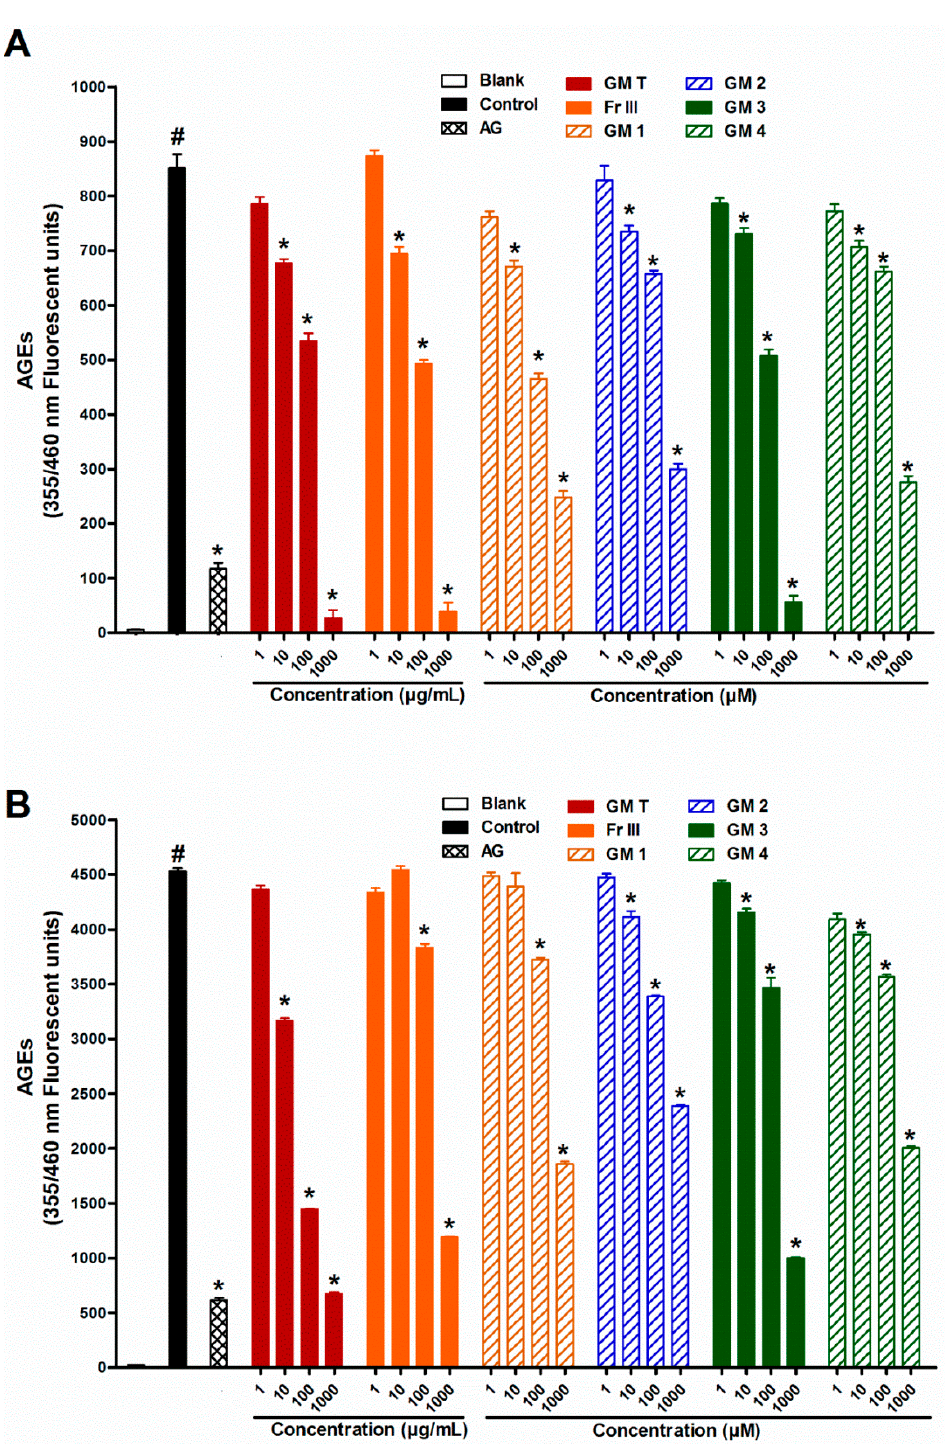
Figure 1. Effect of GMT, Fr III and isolated compounds on the formation of fluorescent AGEs when BSA incubated with with glucose ( A ) or ribose ( B ) at week 4. Blank is a reaction mixture including BSA and glucose or ribose kept at –20 °C while control is the same reaction mixture but incubated at 37 °C. AG was used as standard anti AGEs drug. Results are expressed as mean ± SEM ( n = 3). # p < 0.05 when compared to Blank, * p < 0.05 when compared to Control.